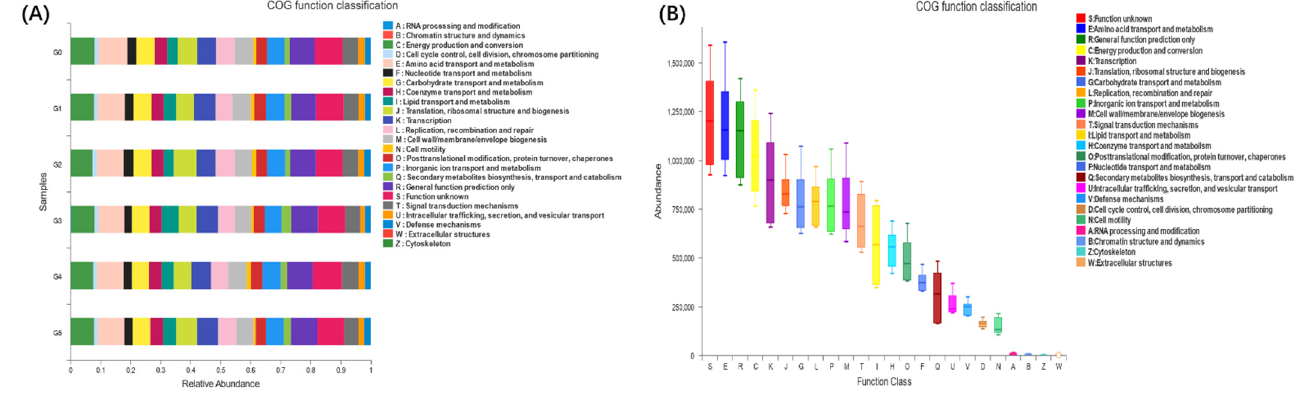
Figure 4. Comparison of the functional classification of COG between all groups. ( A ): COG functional abundance; and ( B ): COG functional relative abundance. n = 3 per group.